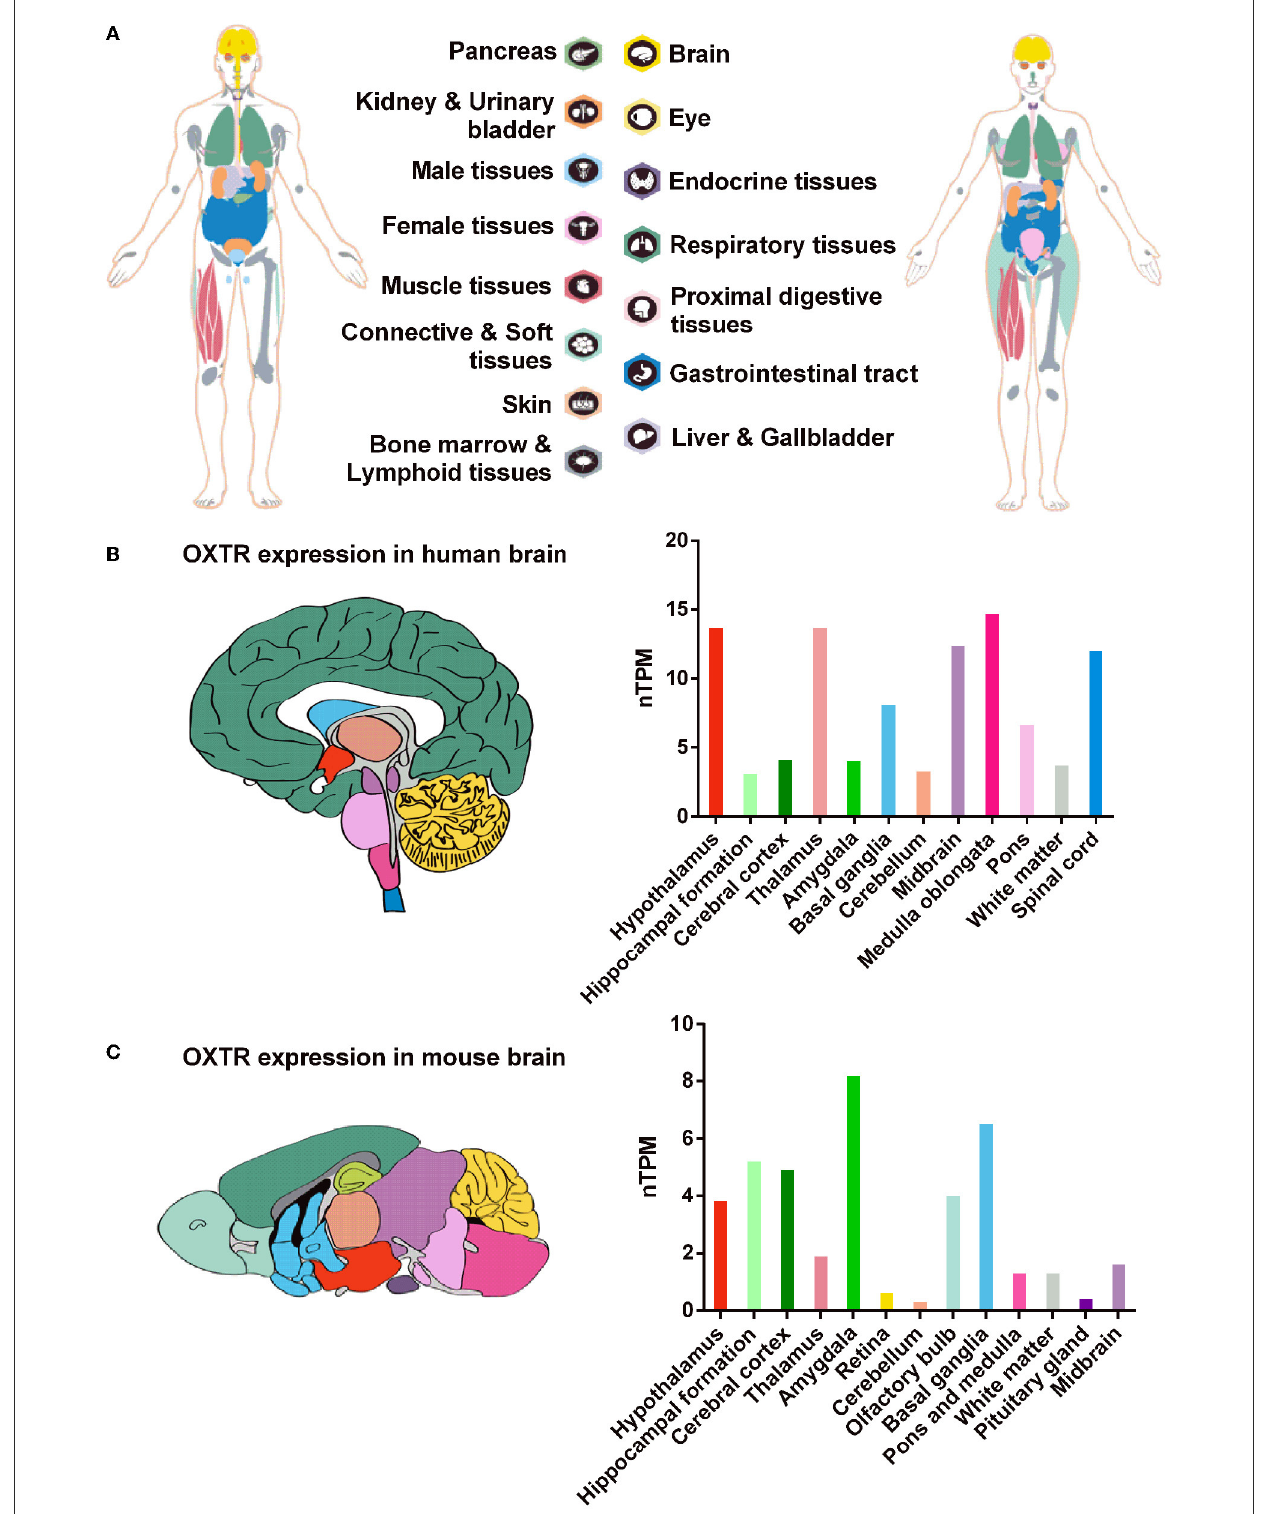
FIGURE2 Tissue distribution of OXTR expression in humans and mice. (A) The OXTR expression in human tissues or organs. (B, C) The relative quantitative RNA expression of OXTR was shown by nTPM (normalized expression) in human and mouse brains. Data were obtained from The Human Protein Atlas, HPA Human brain dataset, and HPA Mouse brain dataset: